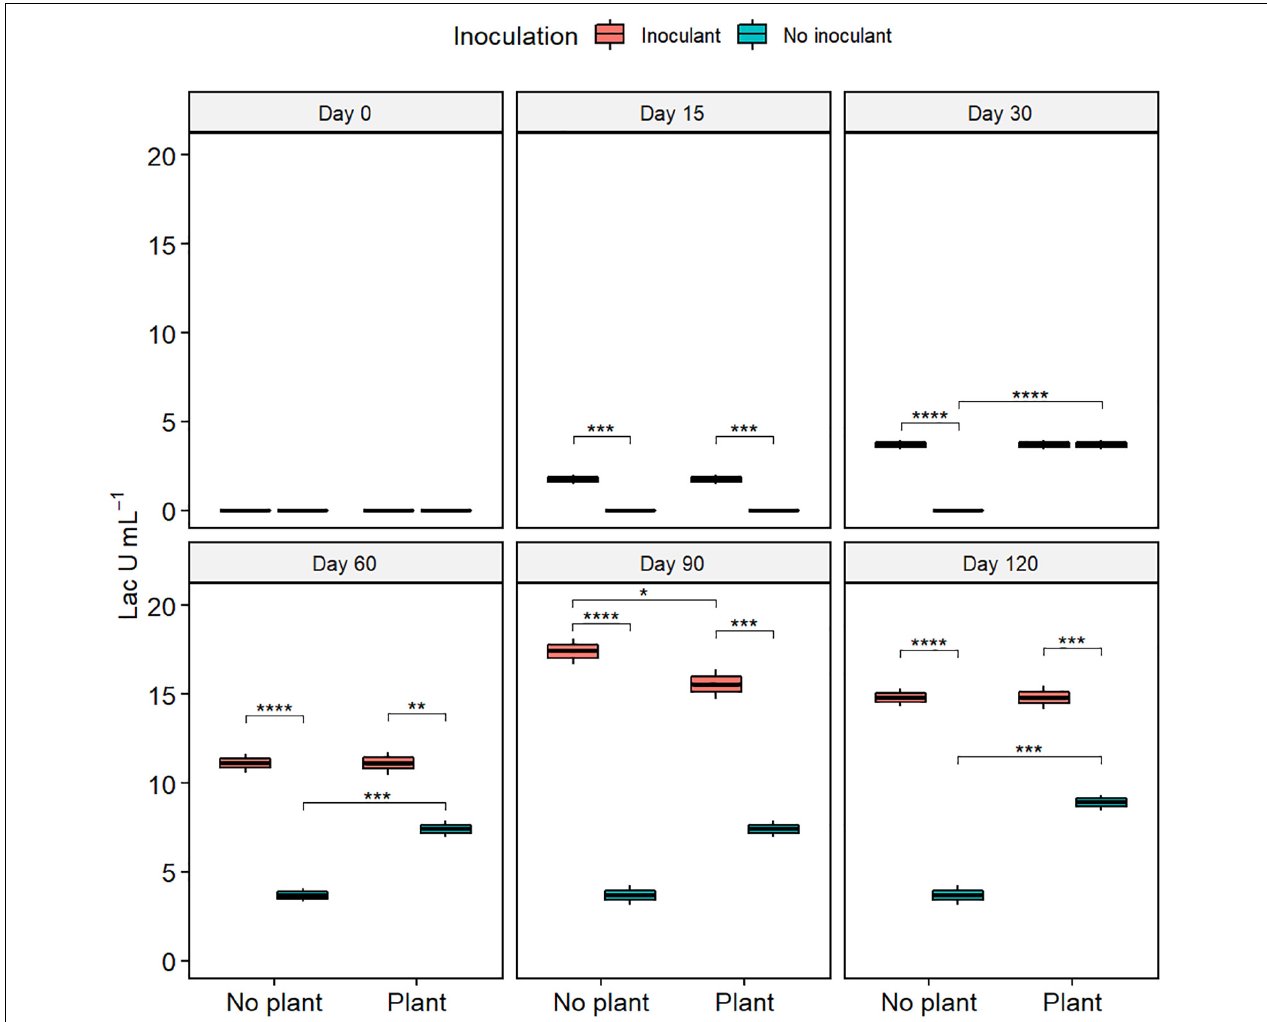
FIGURE 4 | Activity of laccase (Lac) in waste drill cuttings (WDCs). WDCs were incubated in a greenhouse for 120 days with and without black locust ( Robinia pseudoacacia ) plant and with or without bacterial and fungal consortium inoculant. Statistically significant differences are indicated with asterisks: * P <